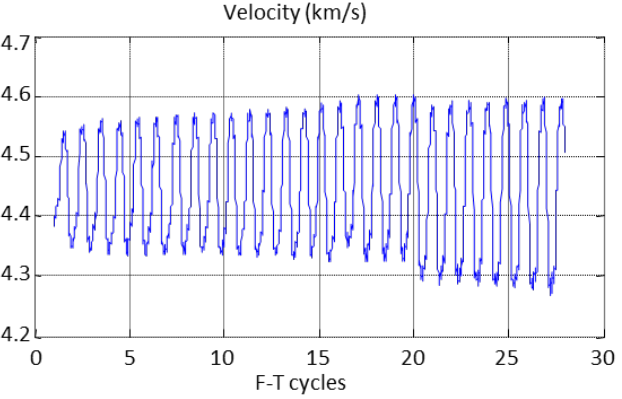
Figure 16. Monitorization of the ultrasonic velocity during the F-T cycles.